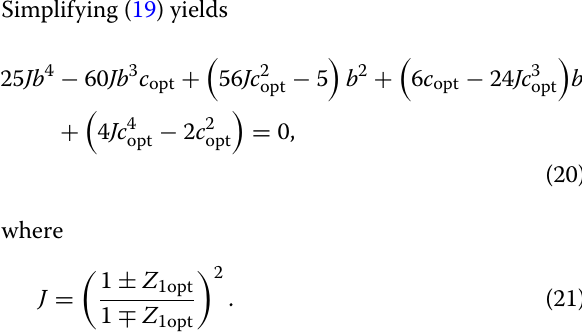
(cid:6) (cid:7) (cid:9) (cid:8) (cid:9) (cid:8) (cid:9) (cid:8) r r 2 r r , E , and F ,0 , C , r , r ,0 . For the a b b c c c − b √ √ 2, and c =